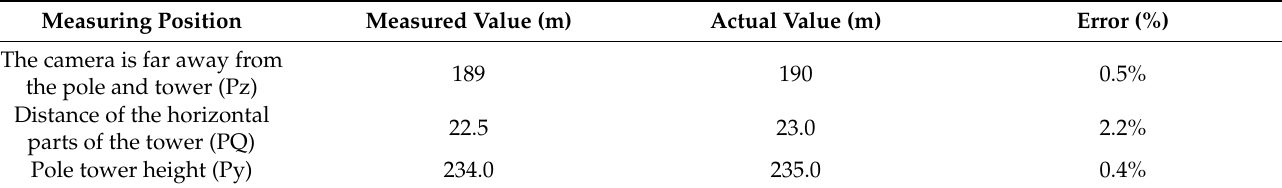
Figure 14. Field test results: ( a ) Pixel position calibration of the tower components; ( b ) Calibration results.